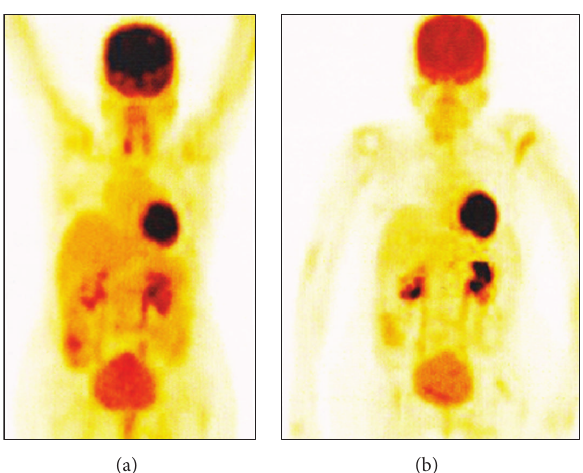
Figure 1: PET-CT images (a) before and (b) after immunotherapy showing the resolution of the lymph node lesions after